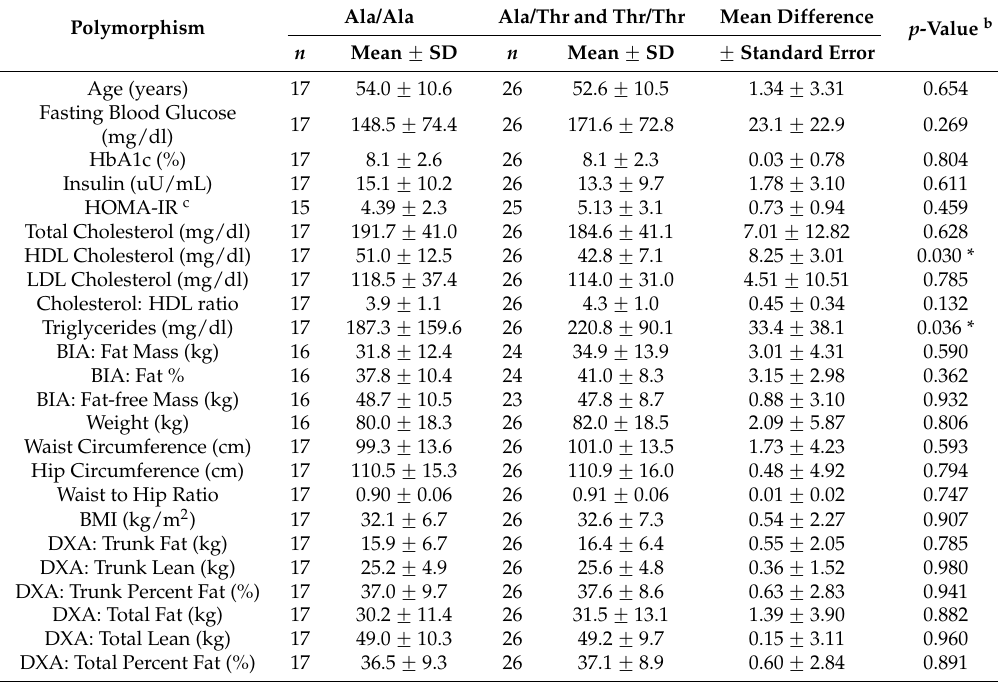
Table 2. Baseline blood glucose, lipid and body composition profiles for the En Balance participants stratified by the FABP2 Ala54Thr polymorphism a